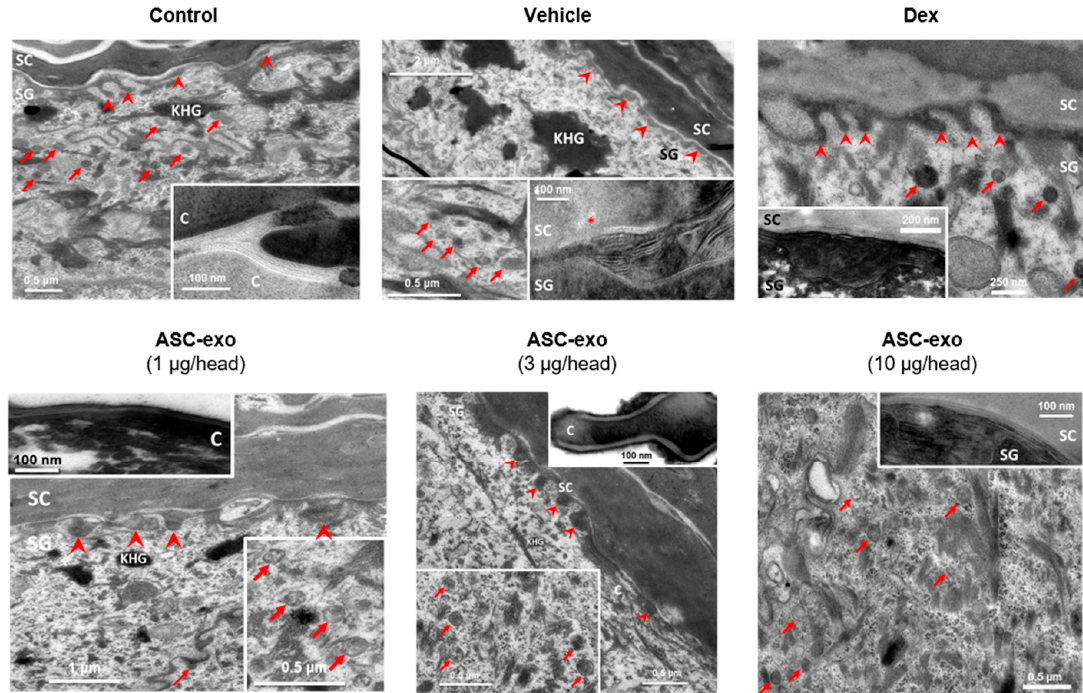
Figure 6. ASC-exosomes restore oxazole-induced defects in the lamellar secretory system. Electron micrographs of epidermis. Inserts show high magnification of lamellar bodies and/or processed lamellar lipids as indicated. Note that lamellar bodies are more abundant at the SG-SC interface in the ASC-exosomes treated group compared with the vehicle and dexamethasone groups. KHG: keratohyaline granules, C: corneocyte, arrows: lamellar bodies, arrow heads: lipid secretion points, *: lipid phase separation (indicating incomplete processing). Scale bar: 100 nm.